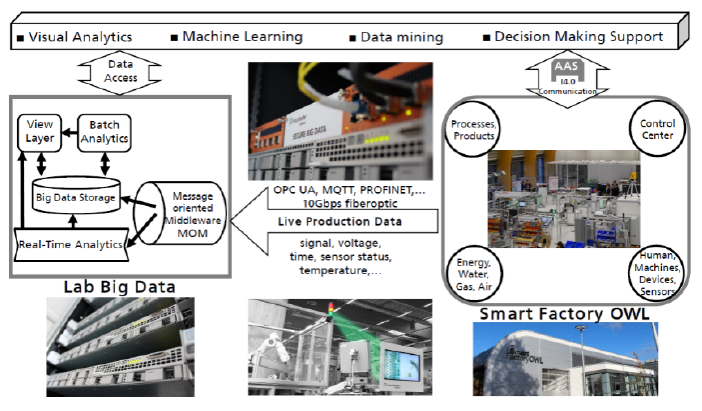
Fig. 7 Alarm display